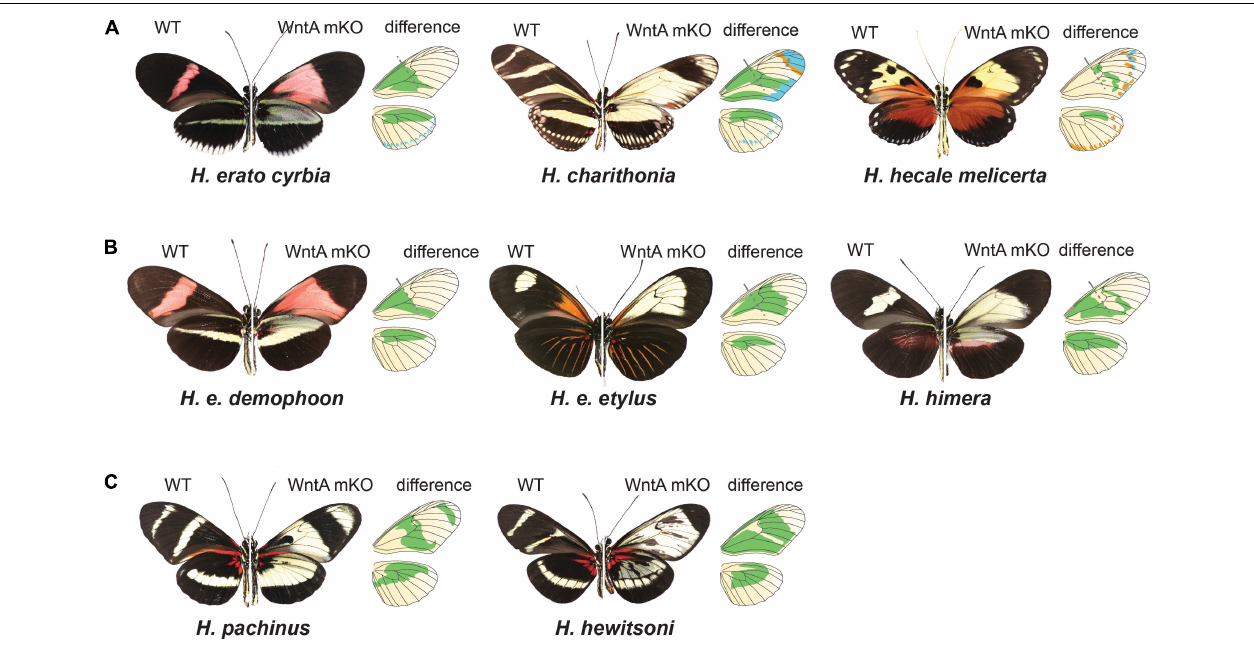
FIGURE 5 | Chance and contingency on a Heliconius wing: CRISPR/Cas9 experiments demonstrate the pervasive role that WntA plays in orchestrating pattern variation and underscores how rapidly the underlying GRNs shaping wing patterns can diverge. (A) WntA seems to be broadly involved in establishing pattern boundaries across the wing and causes shifts in the ultimate scale cell fate in every possible direction. (B) WntA KO effects are highly context specific within H. erato color pattern races. While the same proximal elements are affected, the color switch varies depending on genetic background. (C) The underlying GRNs controlling mimicry have diverged substantially between the MCS/ESS lineages. This is exemplified by the co-mimetic species H. pachinus and H. hewitsoni . WntA KOs in H. hewitsoni affect pattern across most of the forewing, except the most distal regions. By contrast, H. pachinus KO effects extend more distally, and forewing band regions remain unchanged. For each Heliconius wild type and mutant image, we show a drawing of the wings, where green represents the wing color pattern domains that are changed by knocking out the WntA gene. In (A) , light blue represents changes in distal patterns and orange represents an extension of black